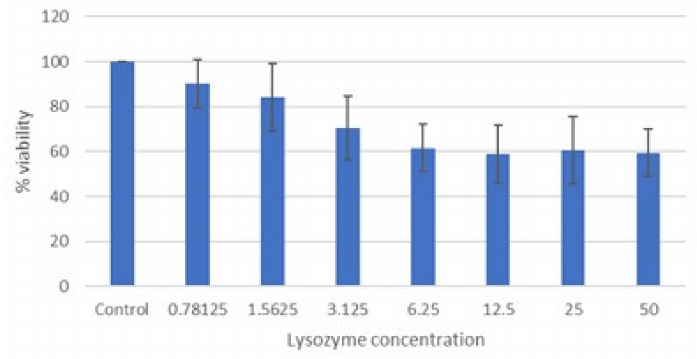
Figure 1. Cytotoxicity of lysozyme HCl (mg/mL) after 72 h of incubation (MTT assay). Cell viability expressed as the percentage of control (untreated) cell viability. Data are expressed as the means ± SD of three independent experiments performed in duplicate.